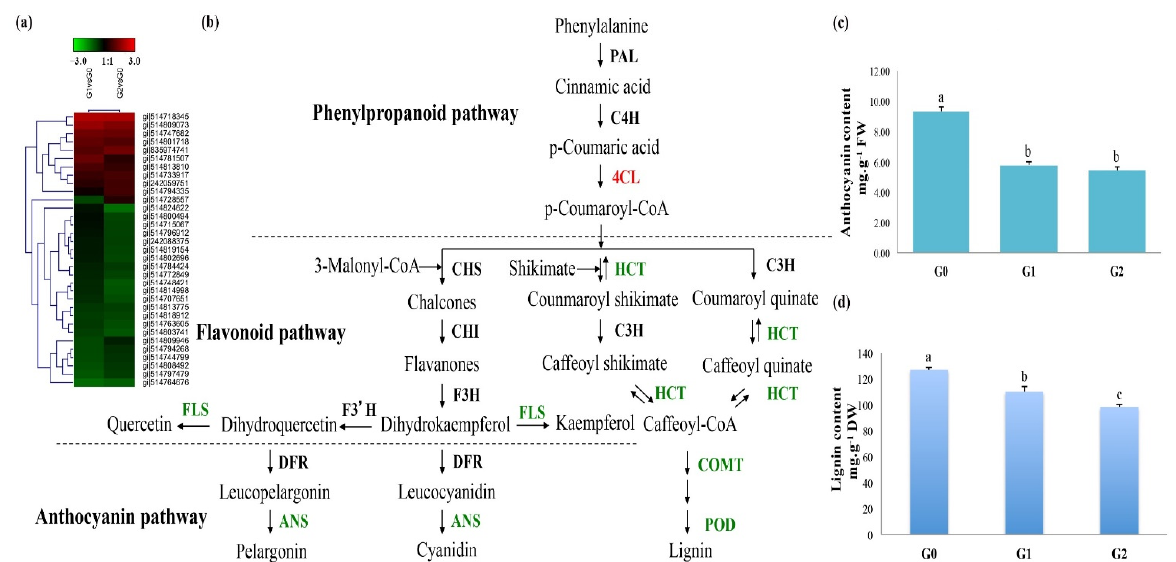
Figure 6. Secondary metabolic pathways involved in C. spinifex drought tolerance. ( a ) Heat map visualization of DAPs involved in secondary metabolism. ( b ) Phenylpropanoid, flavonoid, anthocyanin, and lignin pathways, with red indicating enzymes that are upregulated and green indicating those that are downregulated in response to drought stress. ( c ) Anthocyanin content of the control group (G0) and drought treatment groups (G1 and G2). ( d ) Lignin content of the control group (G0) and drought treatment groups (G1 and G2). Anthocyanin and lignin levels are means ± standard deviations of three replicate measurements per group. Different superscript letters indicate a significant difference ( p < 0.05) between the treatment and control. DW = dry weight. FW = fresh weight.